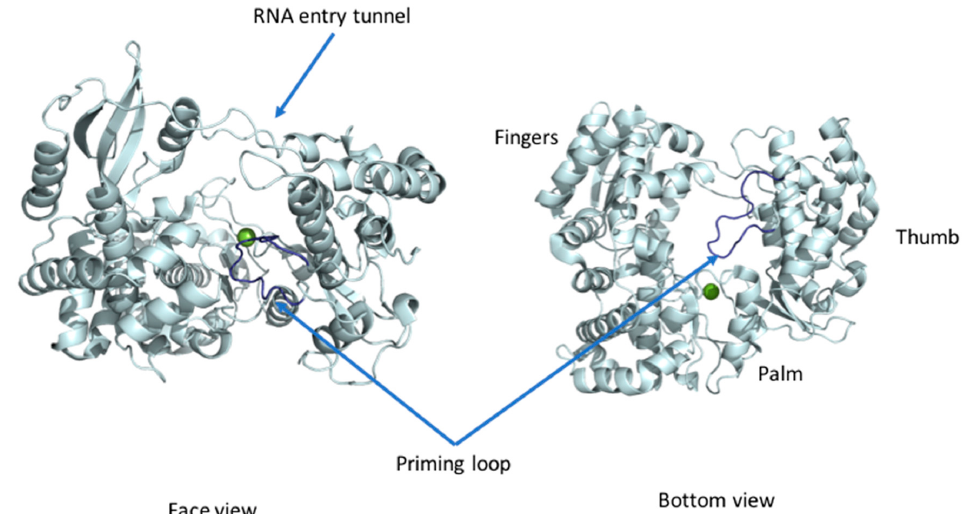
Figure 3. RdRP domain. The RdRp domain of DENV3 NS5 (4V0Q) is represented as ribbons and colored in light blue in front (left) and bottom view (right). The magnesium (green) ions are represented as spheres. The priming loop is colored in dark blue.